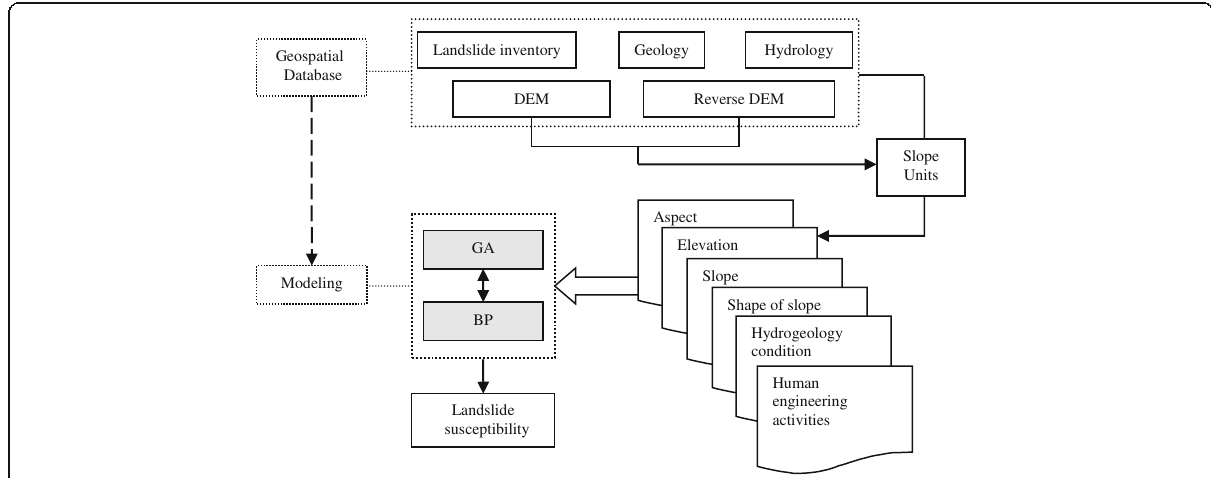
Fig. 11 Framework of landslide susceptibility using GA-based BPNN